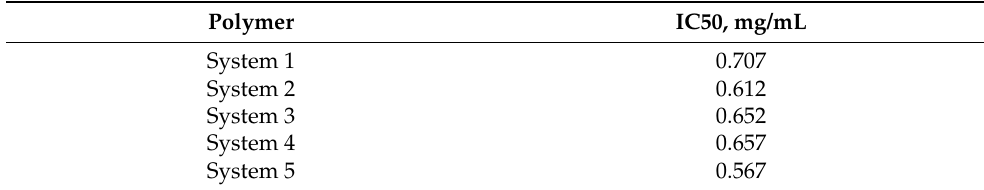
Table 3. IC50 (mg/mL) measured for the polymeric systems in 24 h incubation with macrophages. Polymer IC50, mg/mL